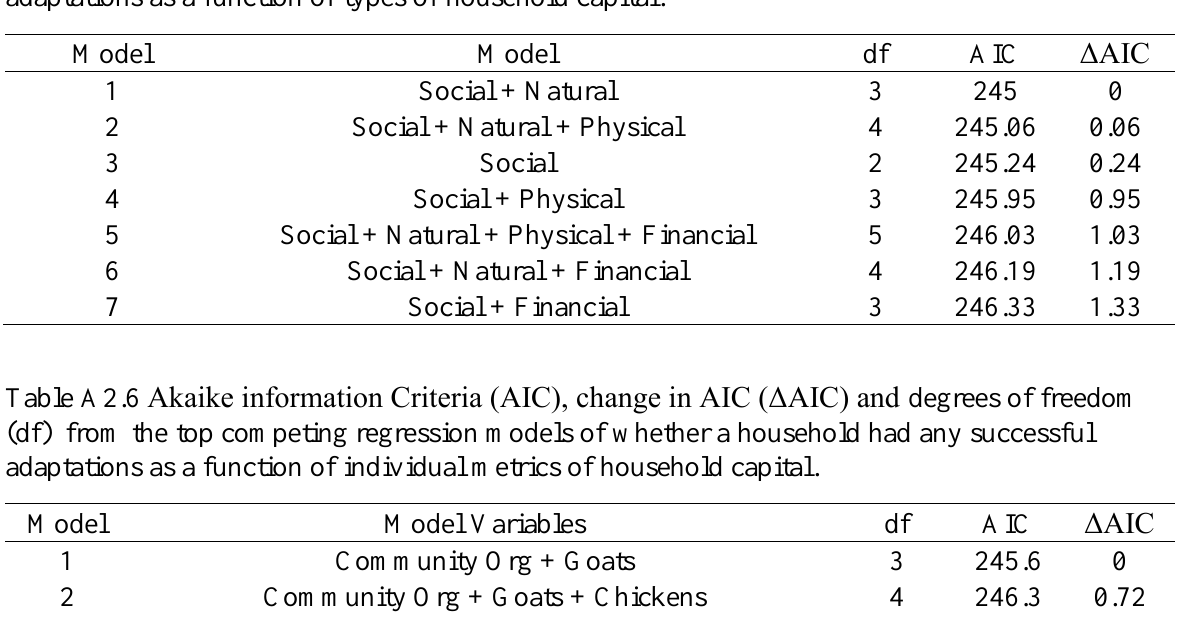
Table A2.5 Akaike information Criteria (AIC), change in AIC (ΔAIC) and degrees of freedom (df) from the top competing regression models of whether a household had any successful adaptations as a function of types of household capital.